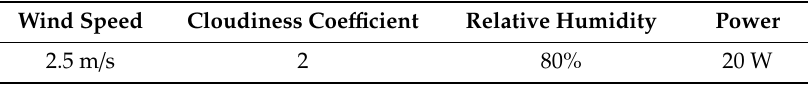
Table 4. Outdoor weather parameters and component power.